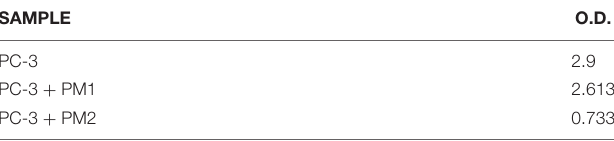
TABLE 4 | MTT assay: spectrophotometric absorbance values at 570 nm.